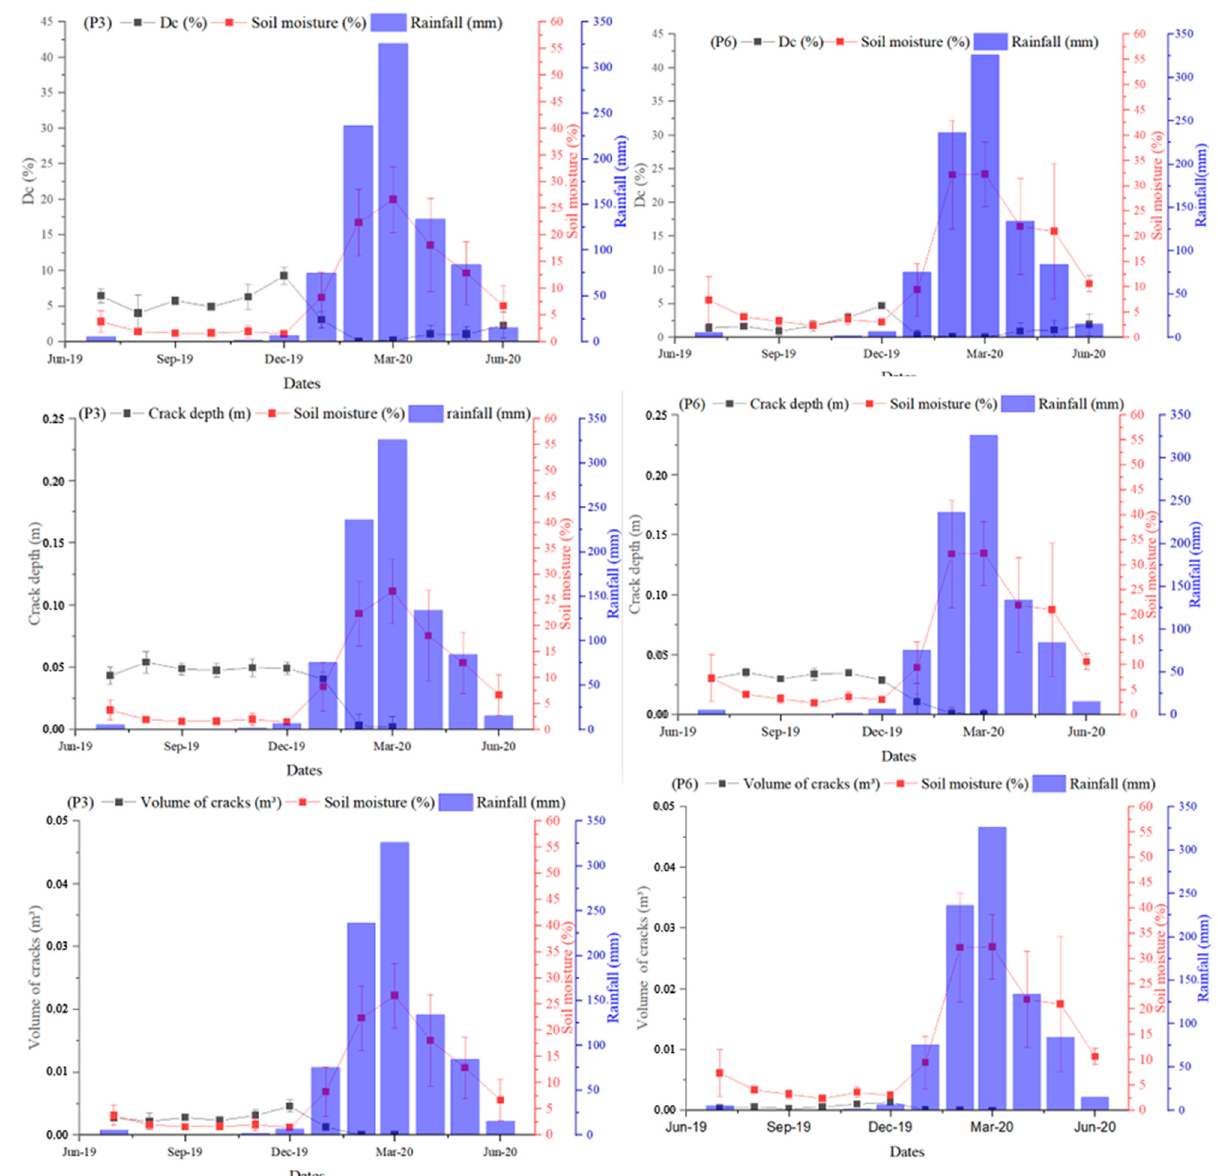
Figure 10. SCL cluster plots P3 and P6—monthly Dc, area, depth, soil moisture and rainfall.